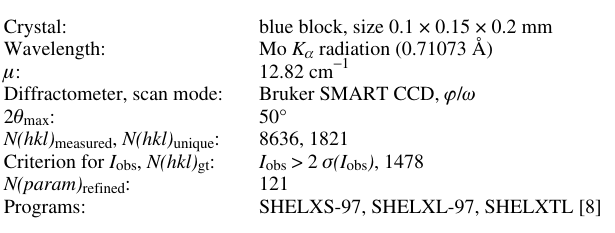
Table 1. Data collection and handling.